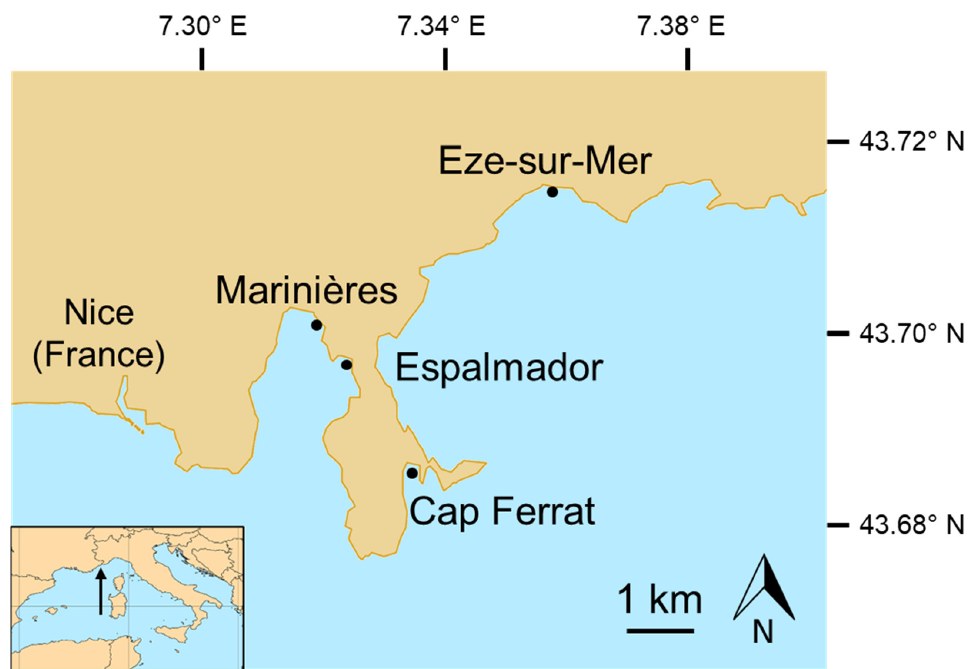
Figure 1. Study locations from west to east: Marinières (43.7053 N, 7.3188 E), Espalmador (43.7000 N, 7.3243 E), Cap Ferrat (43.6858 N, 7.337 E) and Eze-sur-Mer (43.7220 N, 7.3598 E).